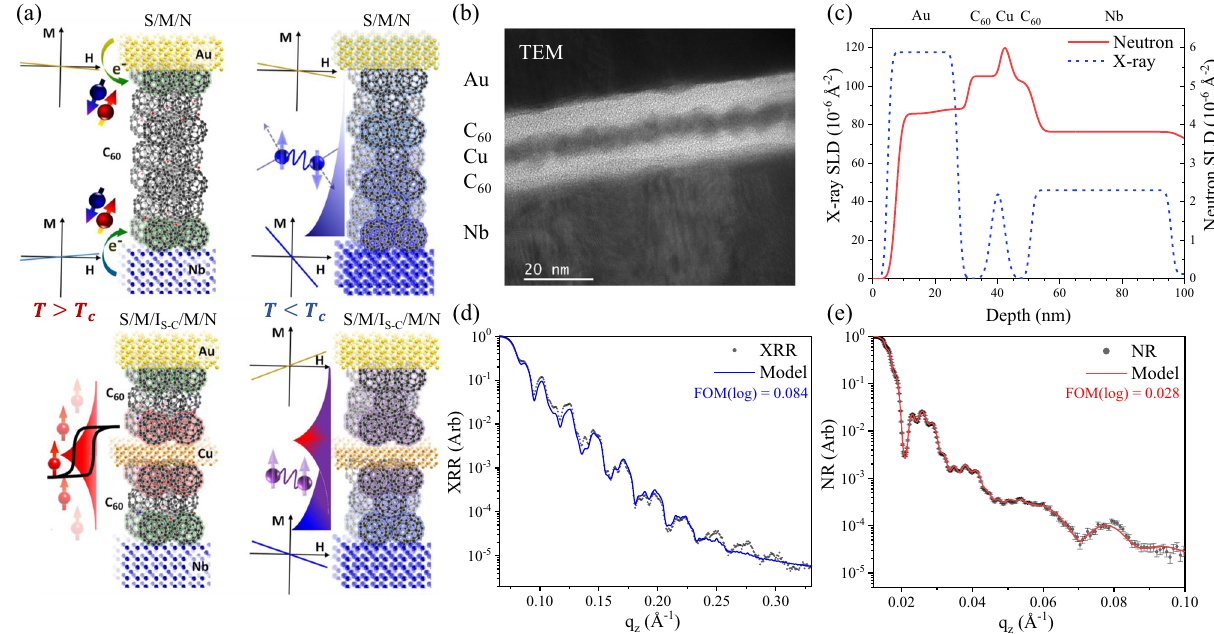
Fig. 1 Structural characterization of a prototypical superconductor/molecular heterostructure. The nominal structure is: SiO 2 /Nb(50)/C 60 (10)/Cu(3)/ C 60 (10)/Au(20) where thicknesses in brackets are in nm. a A schematic demonstrating the proposed coalescence of localised interfacial spin-order and superconducting correlations in hybrid superconductor/molecule/normal metal (S/M/N) and superconductor/molecule/spin-converter interface (S/M/ I S-C /M/N) heterostructures, above and below the superconducting transition temperature, T c . b Transmission electron microscope (TEM) image of the S/ M/I S – C /M/N sample where S, I S – C and N layers are separated by continuous M layers aided by the minimal diffusion of sputtered Cu and Au. c The depth dependence of the fi tted scattering length density (SLD) demonstrates the different sensitivities of neutron (continuous red line) and X-ray re fl ectivity (dashed blue line). By fi tting the X-Ray re fl ectivity ( d ; grey points measurements, blue line model fi t) and Neutron re fl ectivity ( e ; grey points measurements, red line model fi t) with GenX, we con fi rm that the structural morphology is coherent over a larger in-plane length than is captured via TEM: In both instances, we display the logarithmic fi gure of merit generated by